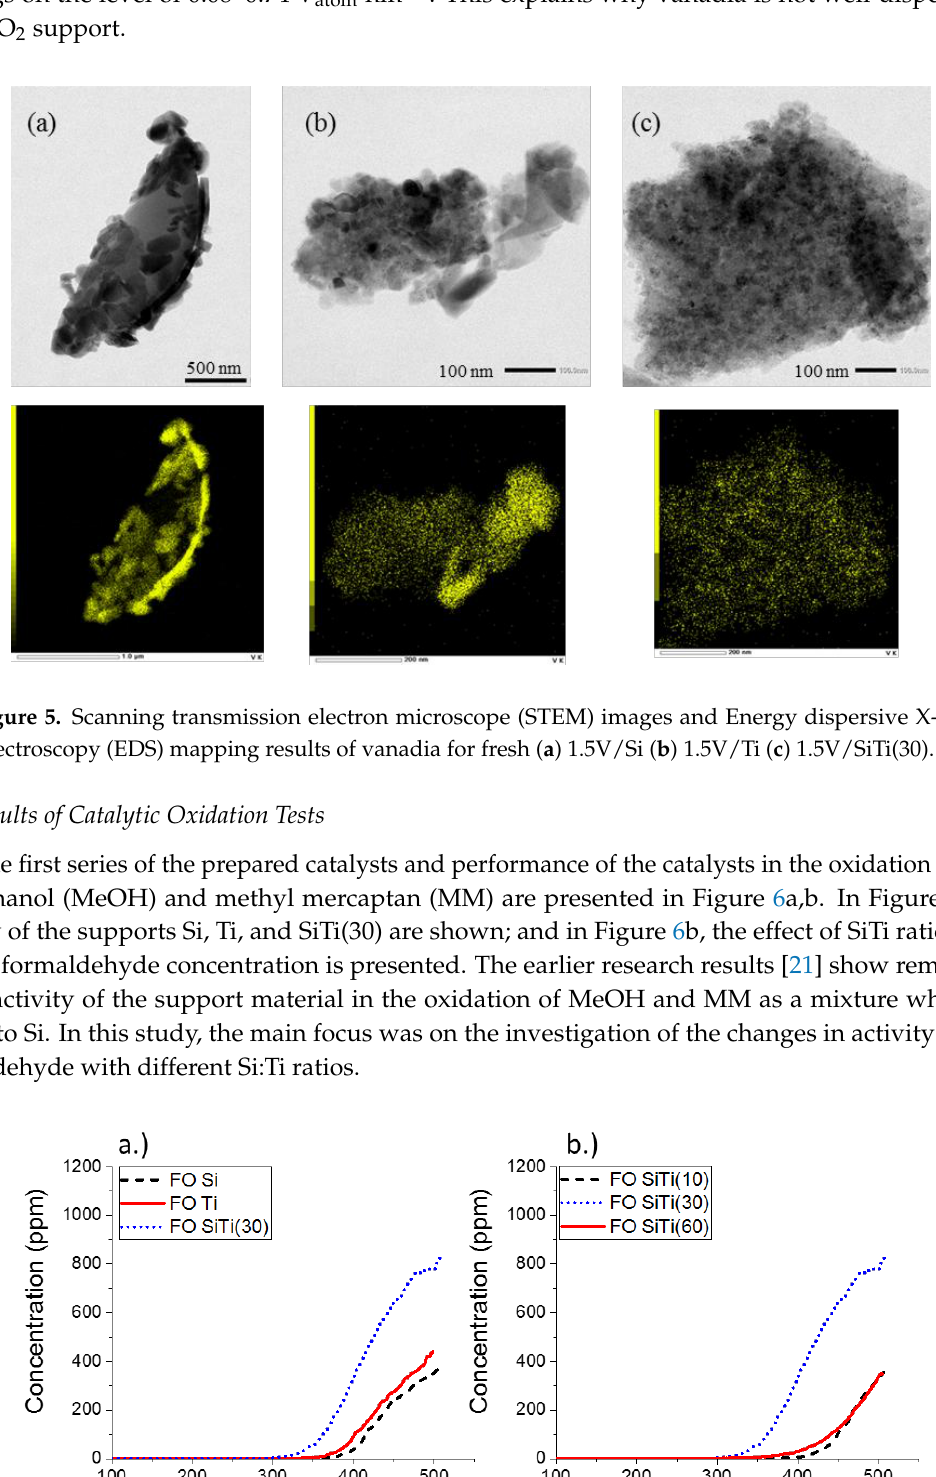
Figure 6. Formation of formaldehyde over ( a ) Si, Ti and SiTi(30) and ( b ) SiTi(10), SiTi(30) and SiTi(60) during the oxidation of methanol and methyl mercaptan (feed 500 ppm + 500 ppm, heating rate 5 °C min −1 ).